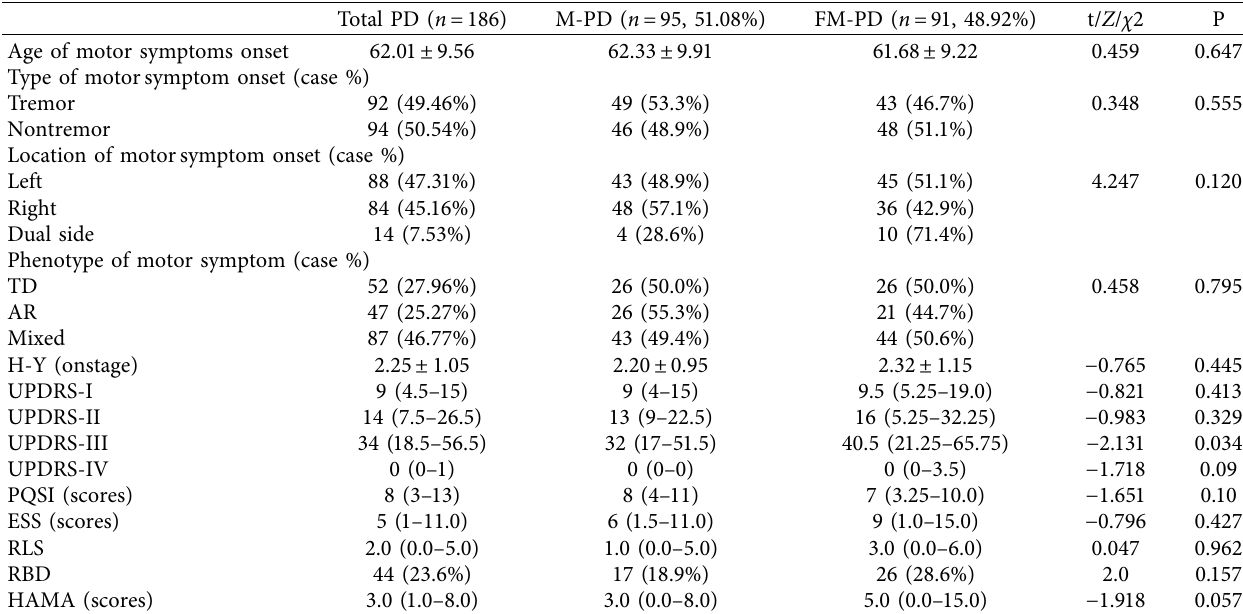
Table 3: Motor symptoms and other nonmotor symptoms in M-PD and FM-PD group